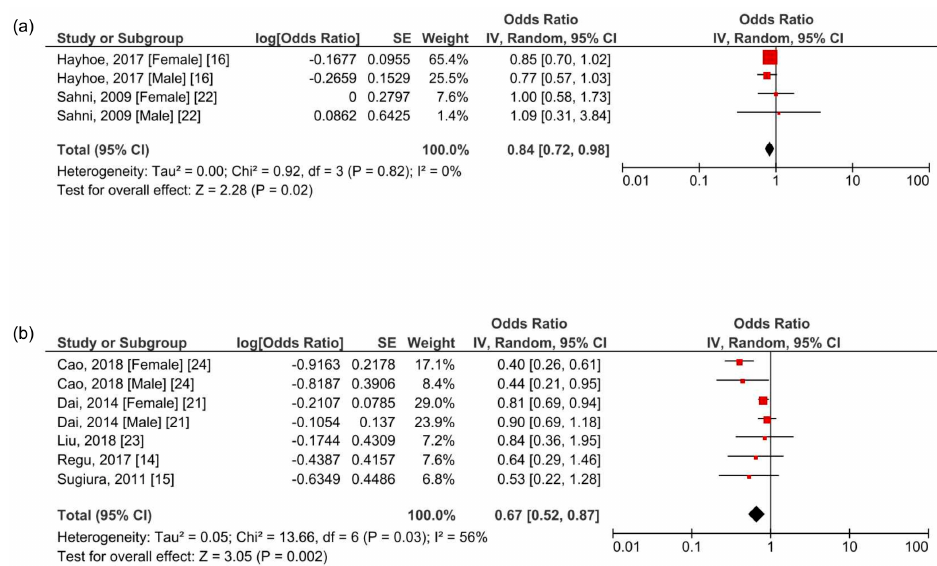
Figure 3. Meta-analysis results of BCX intake and osteoporosis-related outcome by ethnicity. ( a ) Western (the United